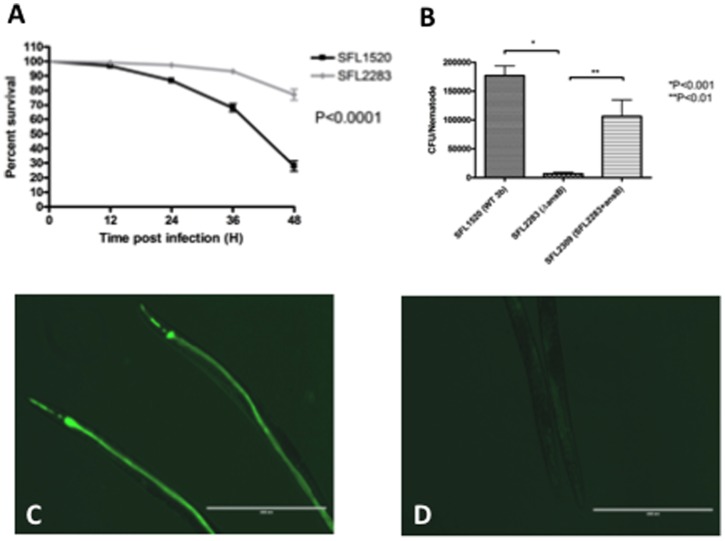
AnsB activity required for S. flexneri-mediated killing and bacterial accumulation in C. elegans.
A: S. flexneri-mediated C. elegans liquid killing assays. 20 synchronized adult nematodes were treated with log phase cultures of S. flexneri 3b (SFL1520-black) or ΔansB (SFL2283-grey) strains grown at 37°C to express virulence factors. Infected nematodes were monitored for 48 hours and survival was scored every 12 hours. Worms treated with the ΔansB strain show a significant increase (p<0.0001, Logrank test) in survival rates compared to nematodes infected with wild type S. flexneri 3b. Error bars represent standard error of mean across at least 3 independent biological repeats. B: Bacterial accumulations assays; young adult hermaphrodite nematodes were fed SFL1520, SFL2283 or ansB complemented strain SFL2309 (SFL2283 + ansB) for 24 hours. 20 nematodes were picked and mechanically disrupted to release internalized bacteria. Diluted lysates were plated on LB agar plates carrying appropriate antibiotics, and colonies were scored in order to quantify S. flexneri cells associated with each nematode. There is a significant decrease in the accumulation of SFL2283 compared to SFL1520 and SFL2309 (p<0.01, One-way ANOVA). Error bars represent standard error of mean across 3 independent biological repeats. Young adult hermaphrodite nematodes infected as above with GFP+- tagged SFL1520 (C) and SFL2283 (D). Wild type S. flexneri 3b accumulates in the nematode gut lumen and ΔansB (SFL2283) strain fails to accumulate in the worm gut lumen. Scale bar = 400 µm.